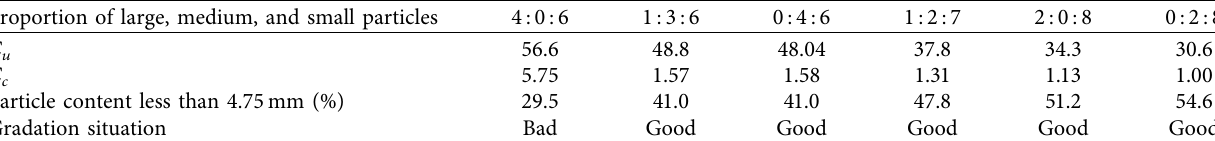
Table 3: Gradation of FSW under each proportion.